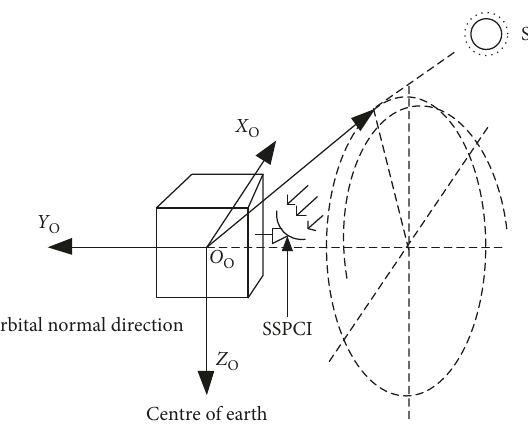
Figure 4: Determination of the mounting